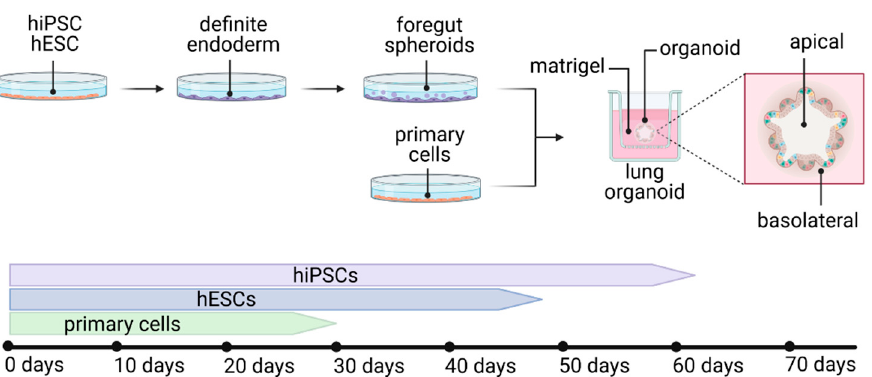
Figure 3. Development of different types of lung organoids from hiPSCs, hESCs or primary cells, with the average duration of development. Figure created with BioRender.com (accessed on 26 March 2021).